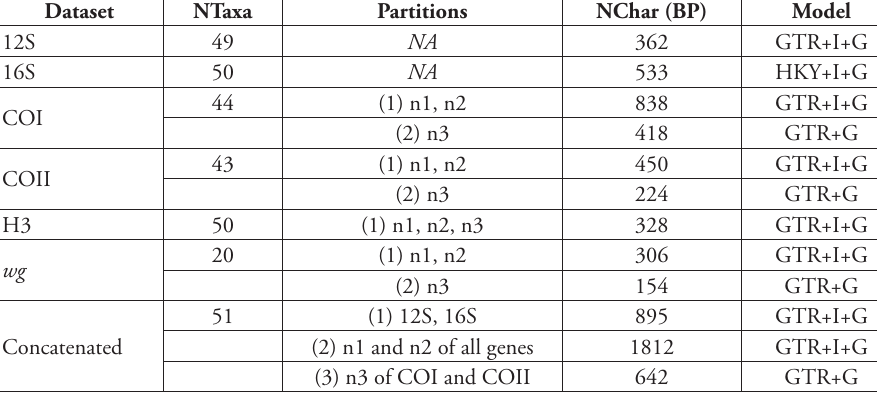
Table 1. Properties of phylogenetic datasets analyzed for this study. NTaxa : The number of taxa repre- sented in the dataset. Partitions : Optimal partitioning scheme chosen by PartitionFinder . NChar (BP) : Number of characters (bases) in the aligned dataset/partition. Model : Optimal model of molecular evolu- tion inferred by either jModelTest (12S, and 16S) or PartitionFinder (protein-coding genes). Dataset NTaxa Partitions NChar